Question: What does this figure show? Answer in one sentence.
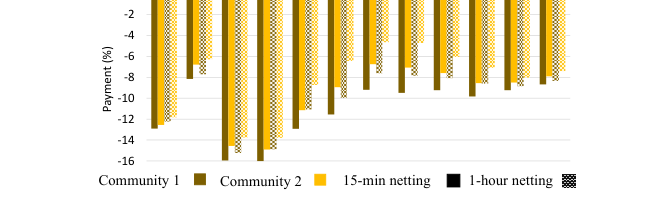
Answer: Community monthly surplus and payment gains (%).